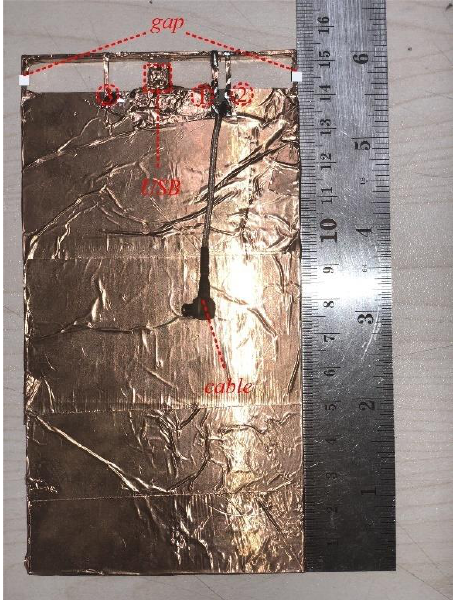
Figure 10. Photograph of the prototype.